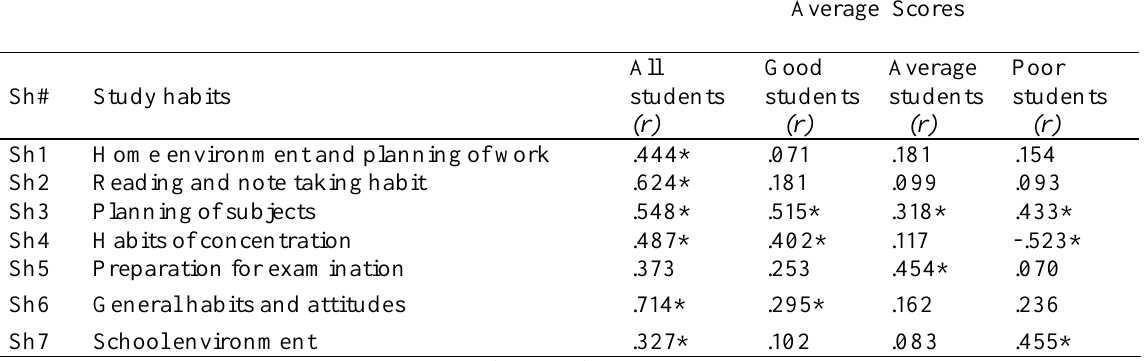
Correlations between Study Habit Scores and Average Scores of the Sub-Groups